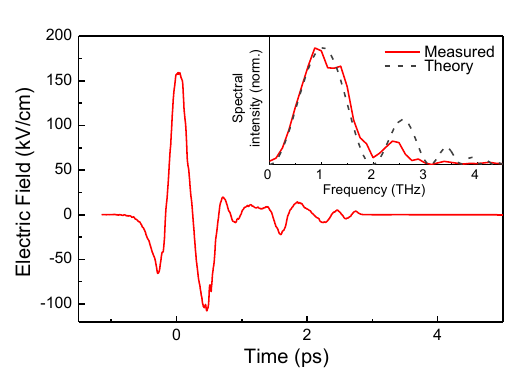
Fig. 3 . THz transient generated in a 300  m thick ZnTe crystal by optical rectification, and corresponding spectrum (inset): the dashed line corresponds to the expected output according to